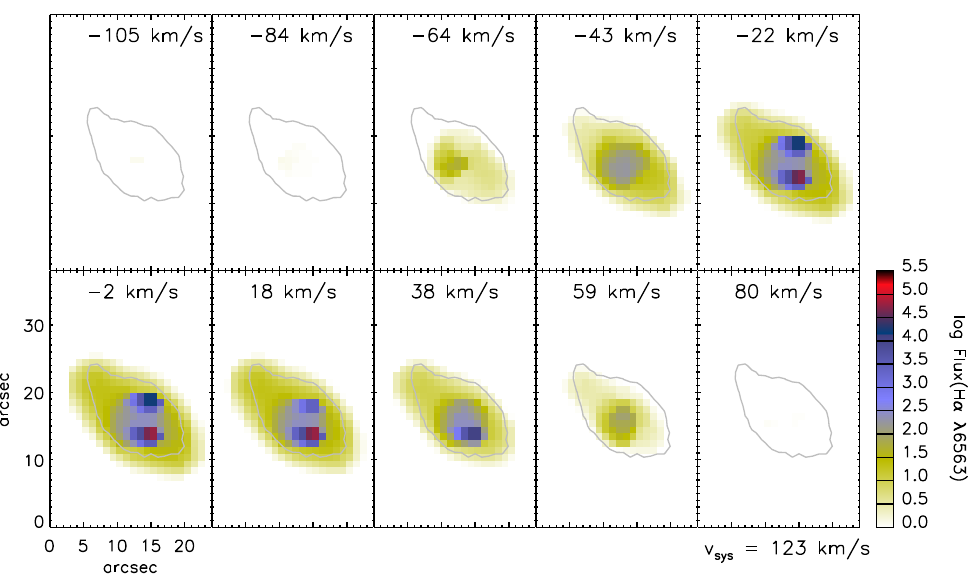
Figure 1. Velocity-resolved flux channels of M2-42 along H α λ 6563 at ∼ 21 kms − 1 intervals with channel velocities specified at the top in kms − 1 . The systemic velocity ( v sys ) in the LSR frame is given in the right bottom corner in kms − 1 unit. The logarithmic color bar is in 10 − 15 ergs − 1 cm − 2 spaxel − 1 unit. The gray contour depicts the boundary of 10 % of the mean H α surface brightness of this object in the SHS. The channels are oriented with north up and east toward the left side. Two bright points over the central shell in the flux maps are associated with H α emission